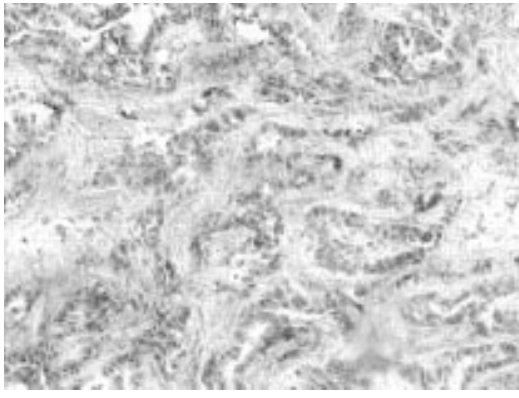
Fig. 2. Ductal carcinoma MG stain (cid:2) 10; 3-chip camera JPG com- pression